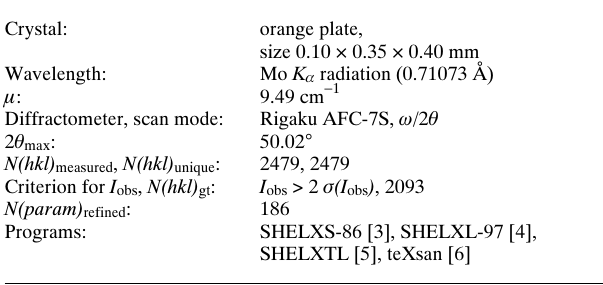
Table 1. Data collection and handling.